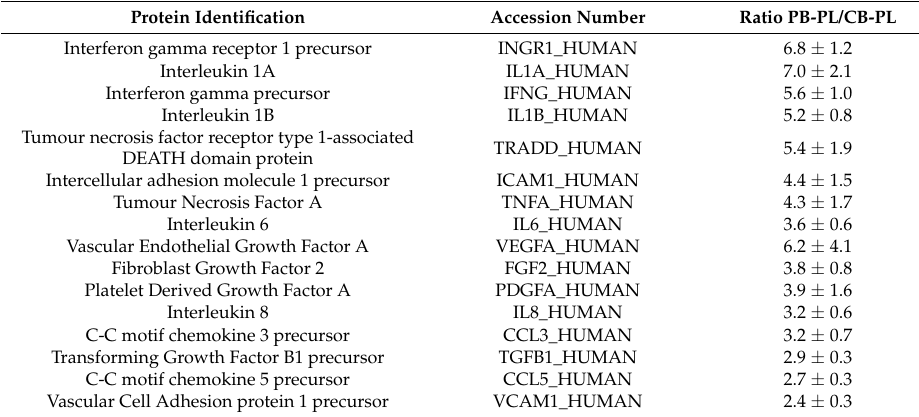
Table 2. Ratio of growth factors in CB-PL and